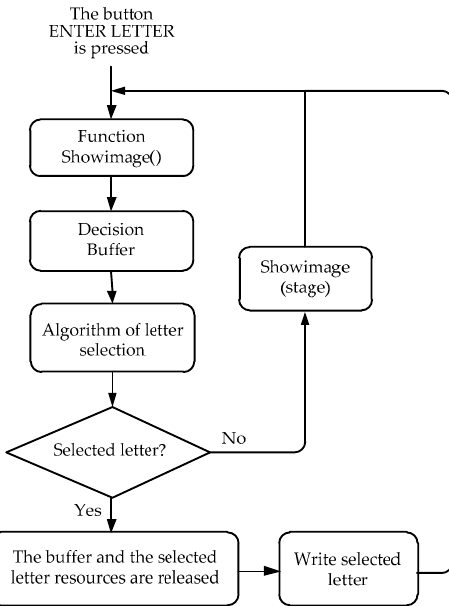
Figure 11. Flowchart of the writing process.